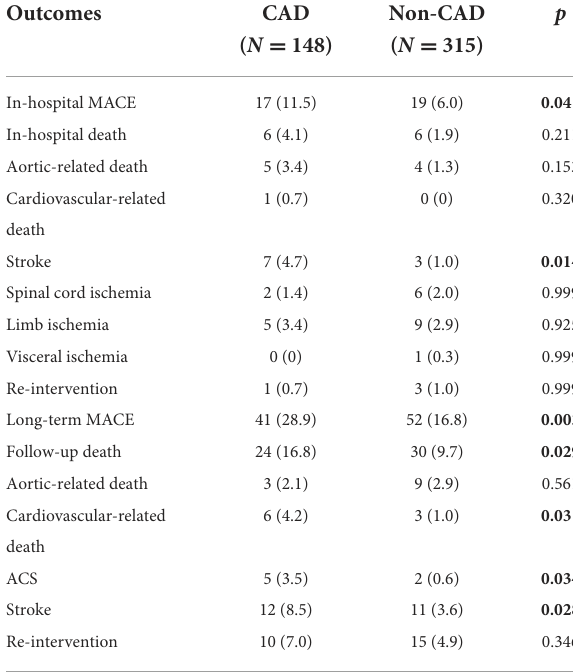
CAD. Outcomes CAD